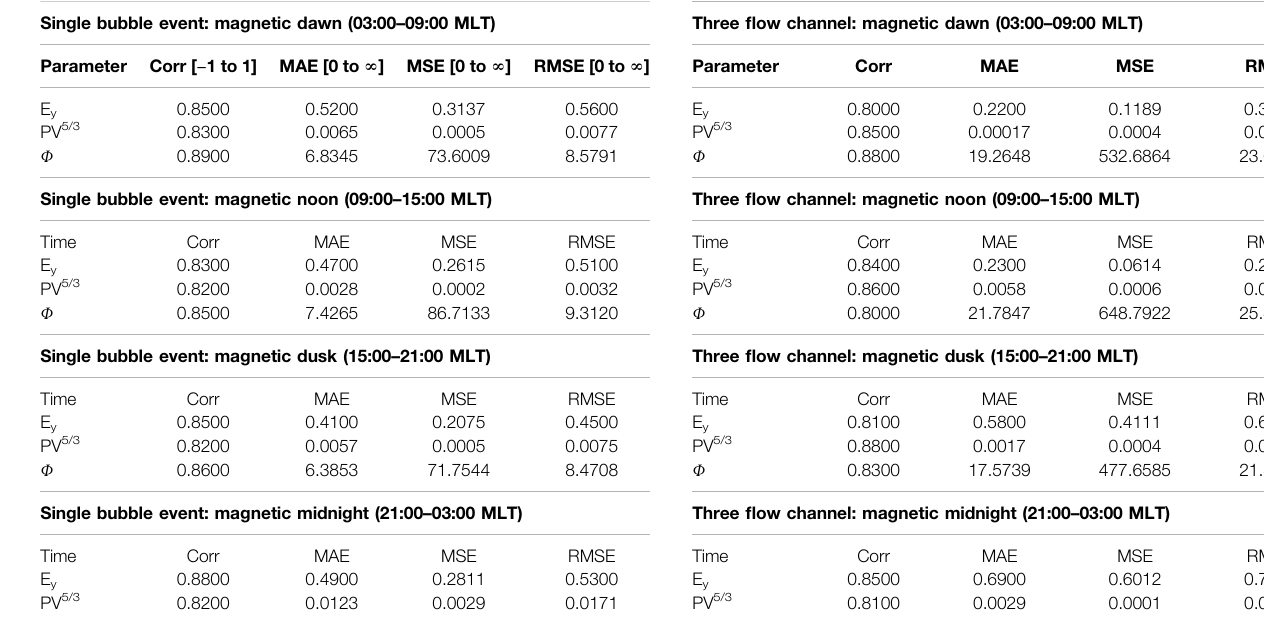
TABLE 3 | Error Analysis for Three Flow